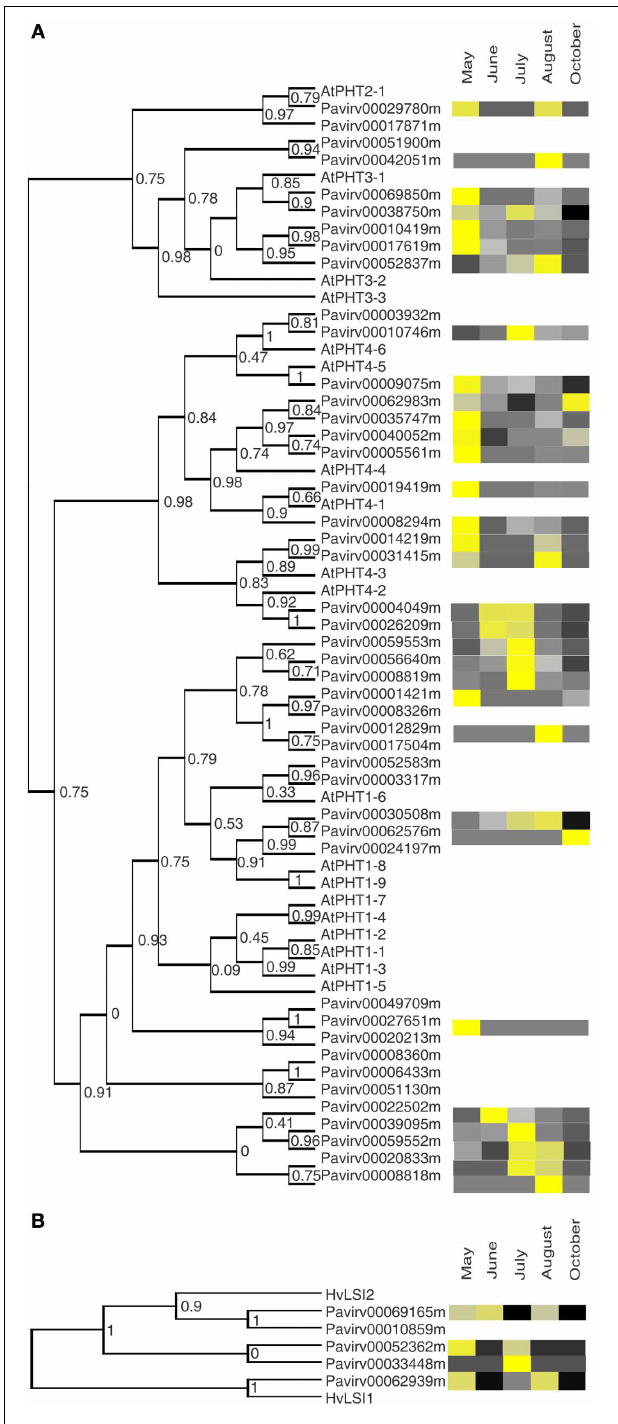
FIGURE 5 | Cladogram of the phylogentic relationships between switchgrass transporter genes to Arabidopsis thaliana (PHT) and barley (Hordeum vulgare; LSi) orthologs and their expression profiles in crowns and rhizomes of field grown cv Summer plants. (A) Phosphate transporters (PHT) (B) Silicon transporters (LSi). Other details are as described for Figure 2